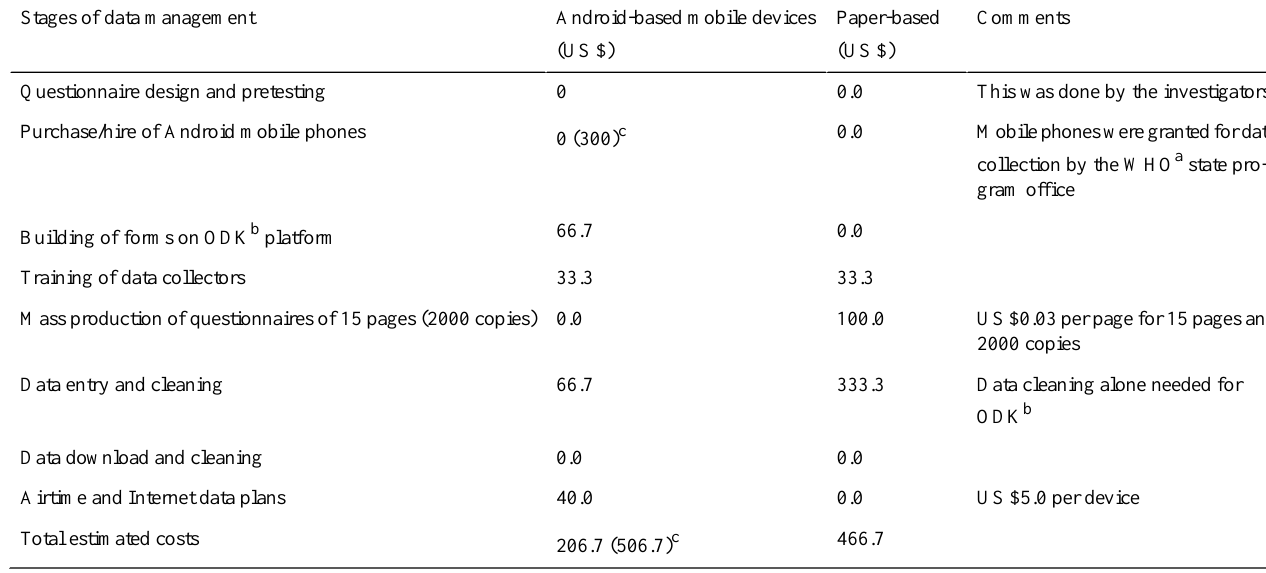
Table 5. Implementation cost (comparing cost elements between paper-based and Open Data Kit phone).